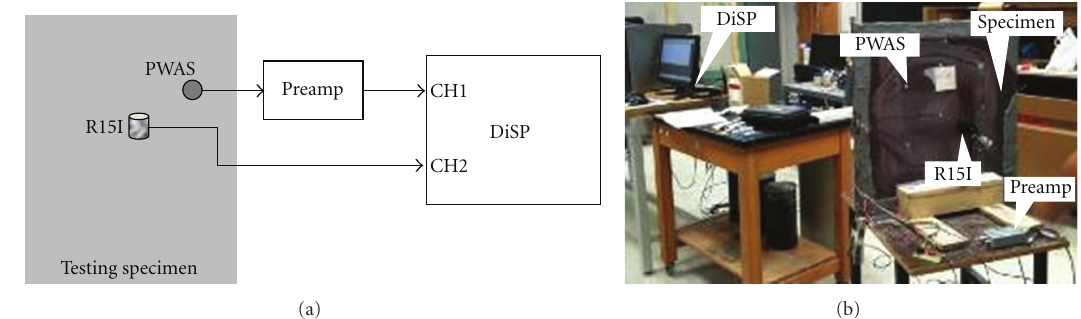
Figure 3: AE testing setup. (a) Test setup schematic; (b) laboratory test setup.